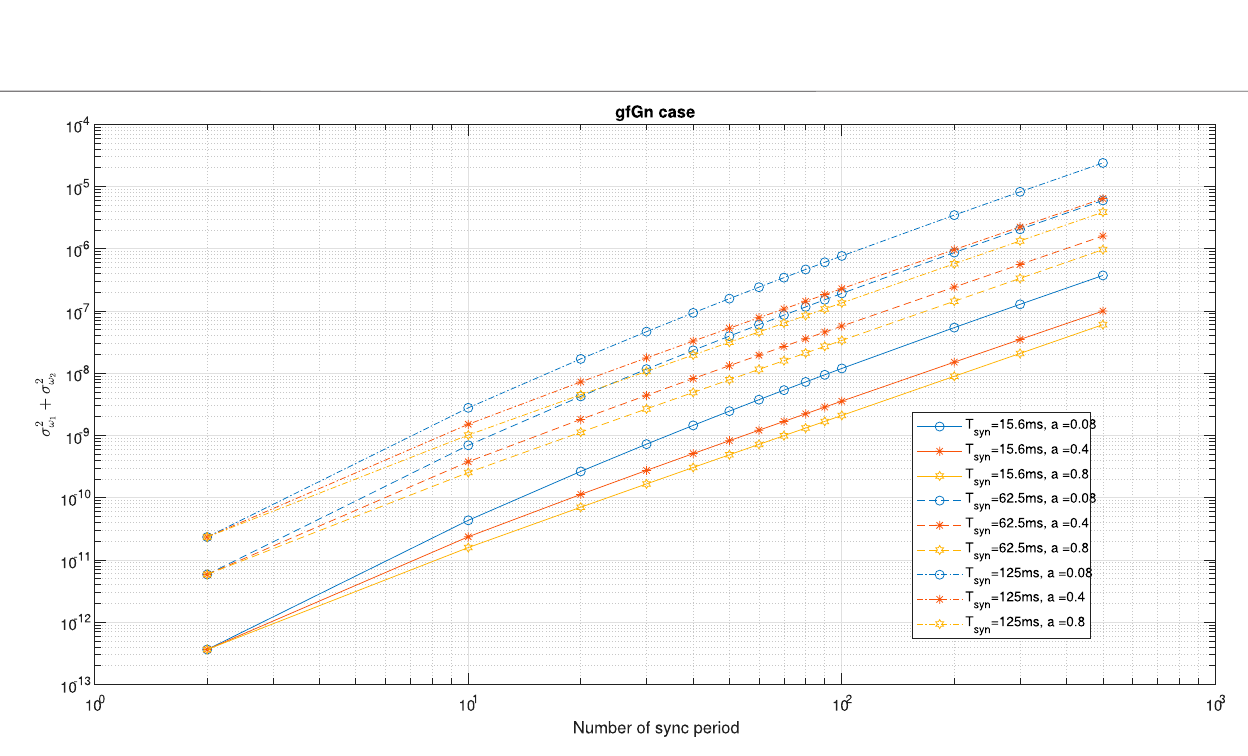
Frontiers in Physics |